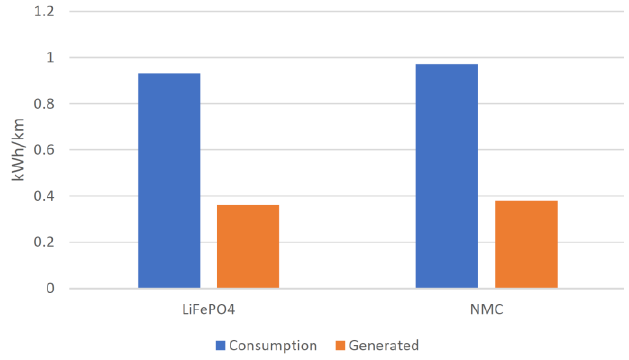
Figure 7. Energy balance (net energy consumption), according to battery type.